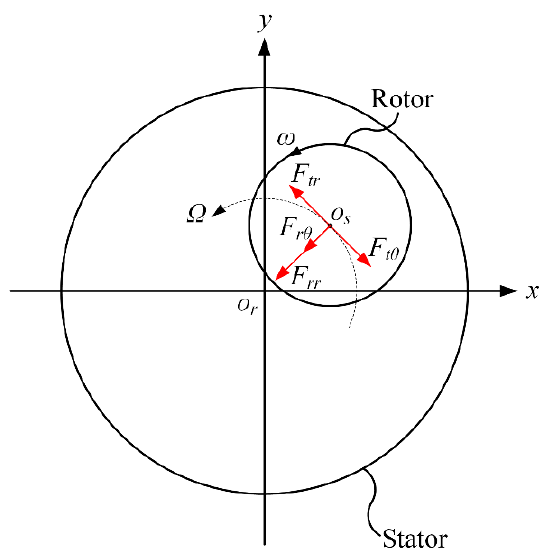
Figure 1. Fluid-induced forces acting on the whirl rotor.